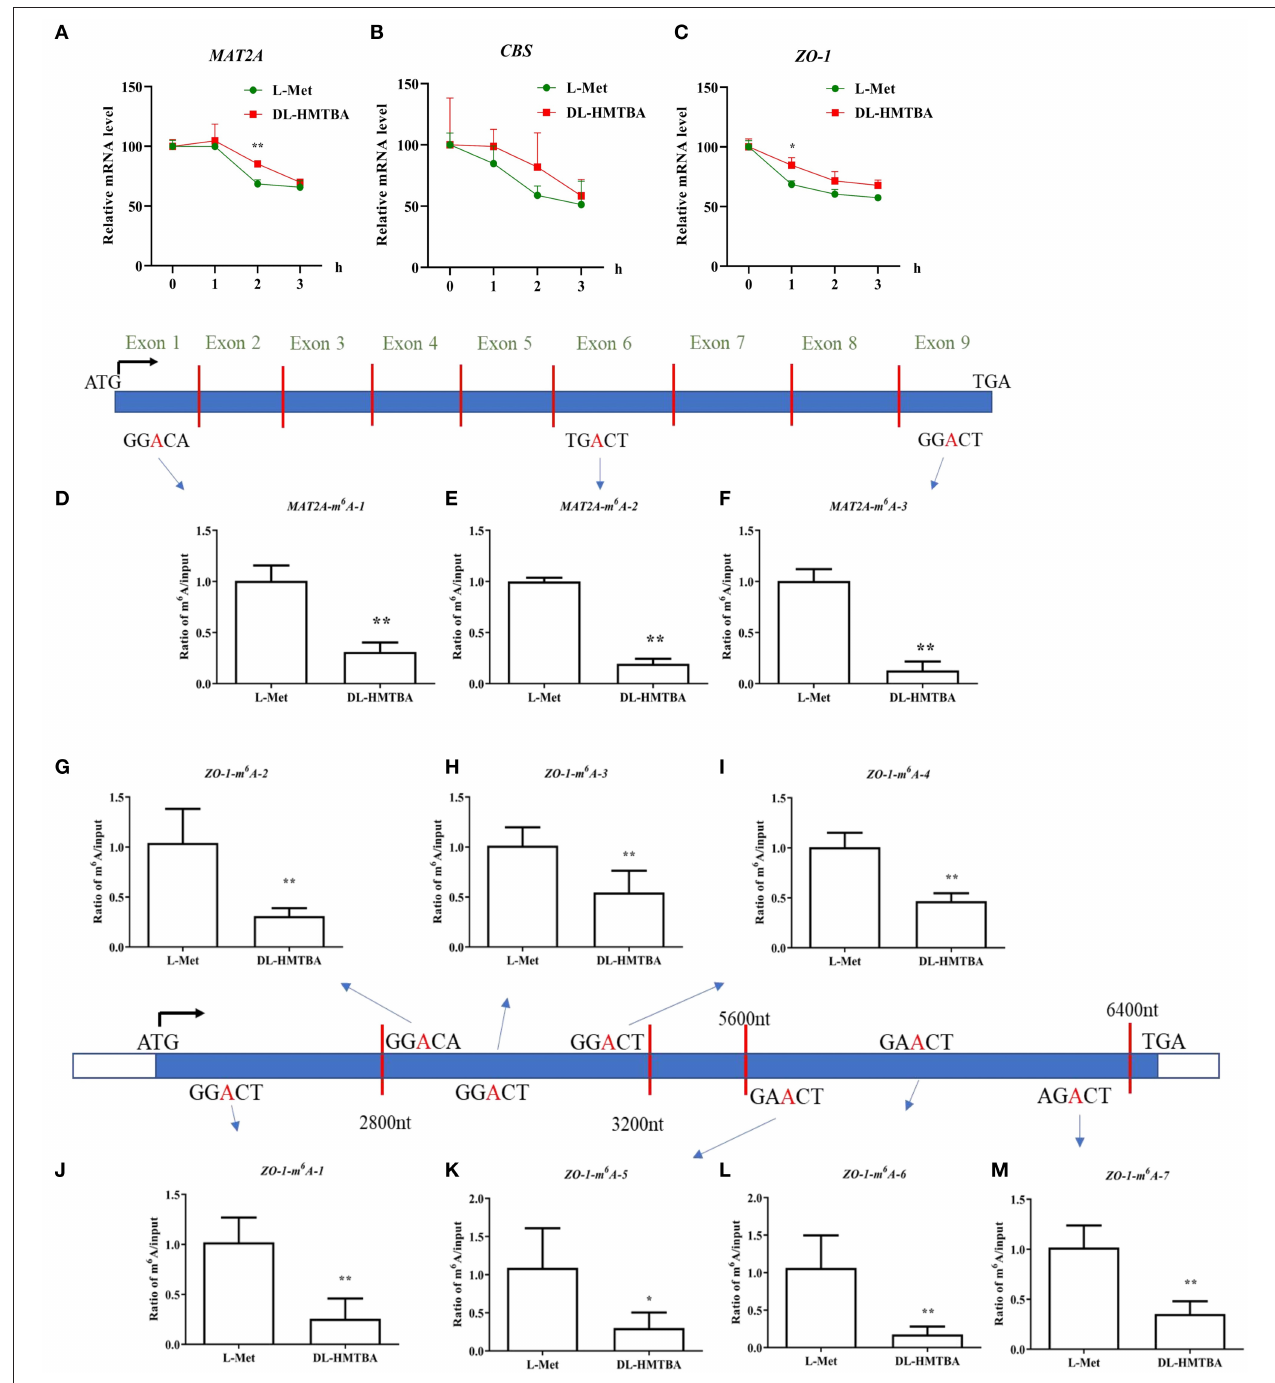
FIGURE 6 | Effects of L-Met and DL–HMTBA on the mRNA stability and their m 6 A modification level of differentially expressed mRNA in IPEC-J2 cells. (A) mRNA stability of MAT2A; (B) mRNA stability of CBS; (C) mRNA stability of ZO-1; (D) The m 6 A modification site 1 of MAT2A; (E) The m 6 A modification site 2 of MAT2A; (F) The m 6 A modification site 3 of MAT2A; (G) The m 6 A modification site 1 of ZO-1; (H) The m 6 A modification site 2 of ZO-1; (I) The m 6 A modification site 3 of ZO-1; (J) The m 6 A modification site 4 of ZO-1; (K) The m 6 A modification site 5 of ZO-1; (L) The m 6 A modification site 6 of ZO-1; (M) The m 6 A modification site 7 of ZO-1; Cells were cultured without fetal bovine serum for 18h and then without Met for 6h, then, different ratios of L-Met and DL–HMTBA were given for 2h (total methionine source concentration is 5mM). Values are means ± SEM, n = 3; ** p < 0.01, * p < 0.05.